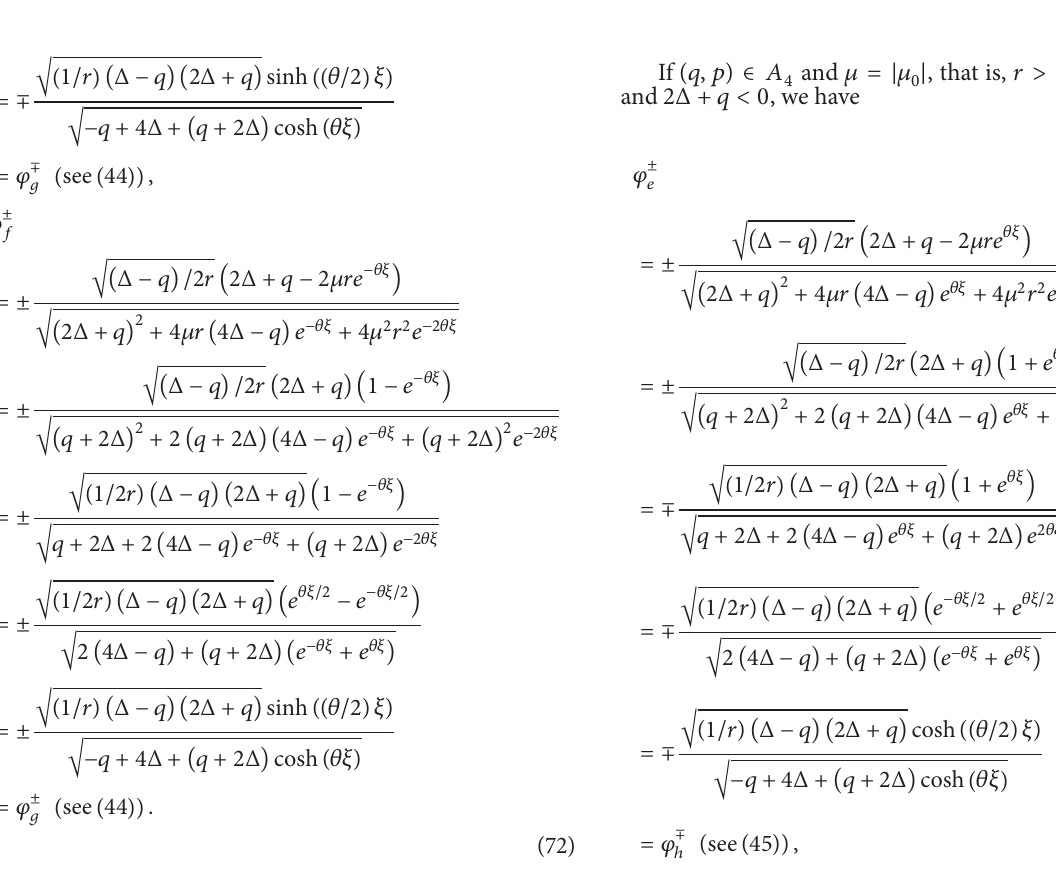
: 𝑝 = 𝑞 2 /4𝑟 = −4, and 𝜇 = 1 and (a) 𝑝 = −3.5 , (b) 𝑝 = −4 + 10 −1 , (c) 7